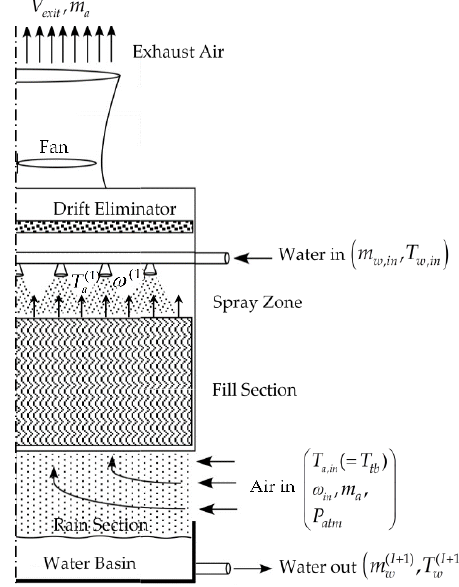
Figure 1. Flow through a counter-flow cooling tower.